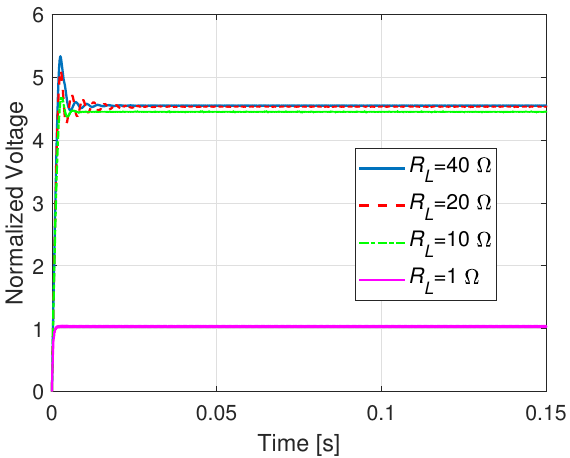
Figure 10. Load normalized voltages assuming h = 10 cm, ρ = 0.5 cm and varying the load resistance R L